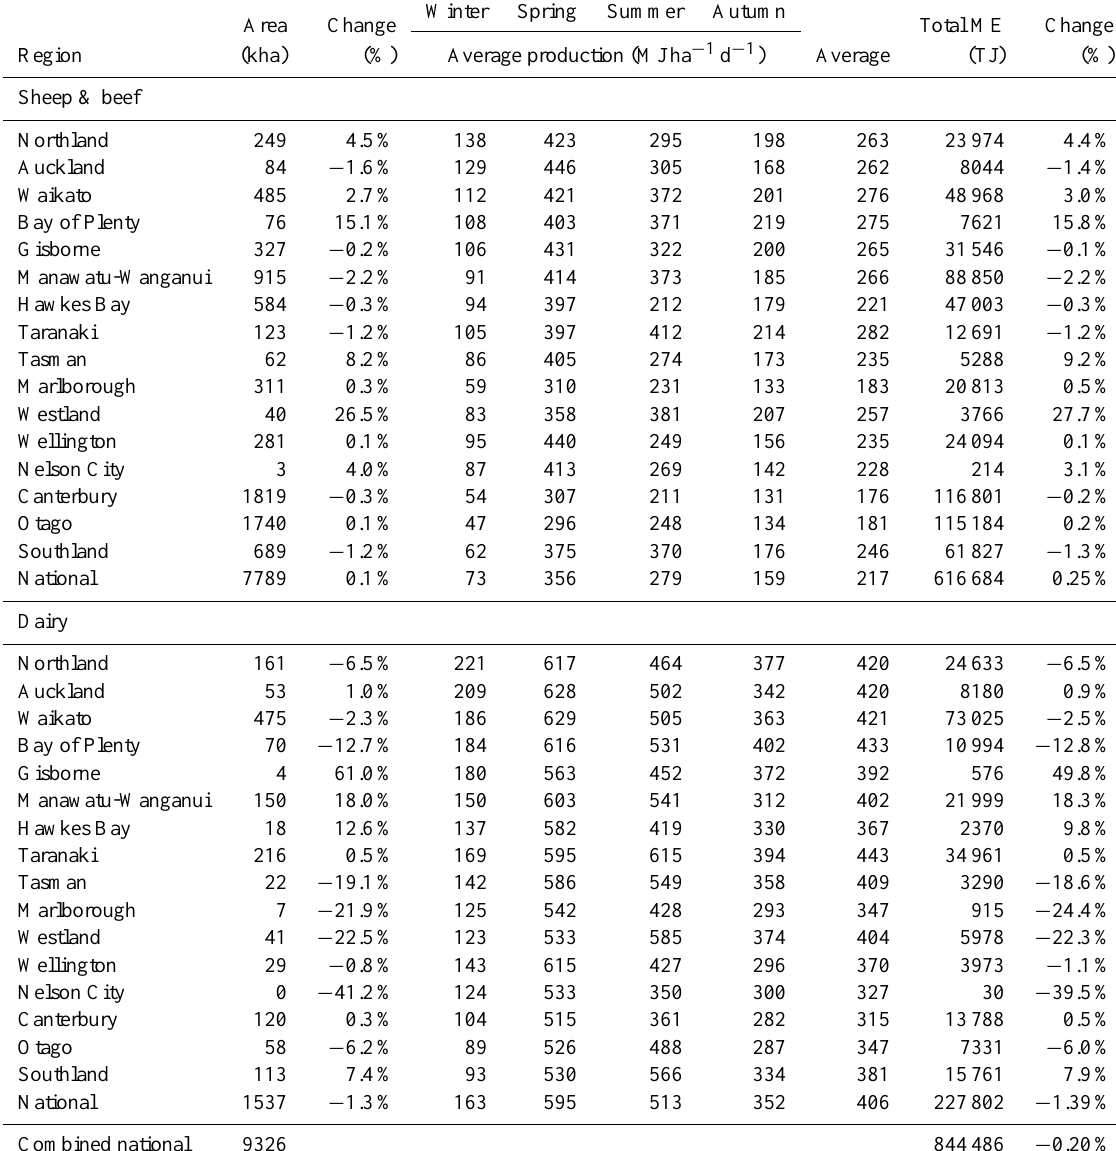
Total ME Change